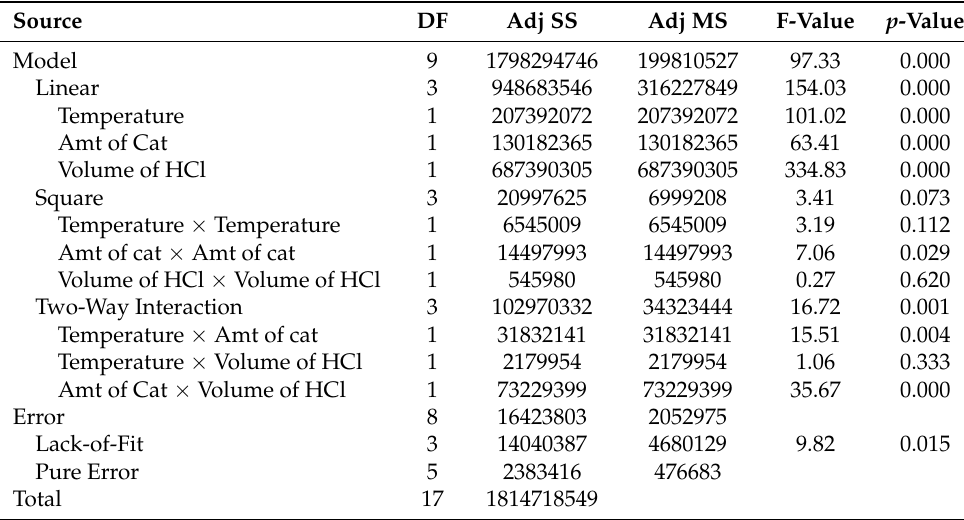
Table 2. Analysis of variance for NiCr experiment system.